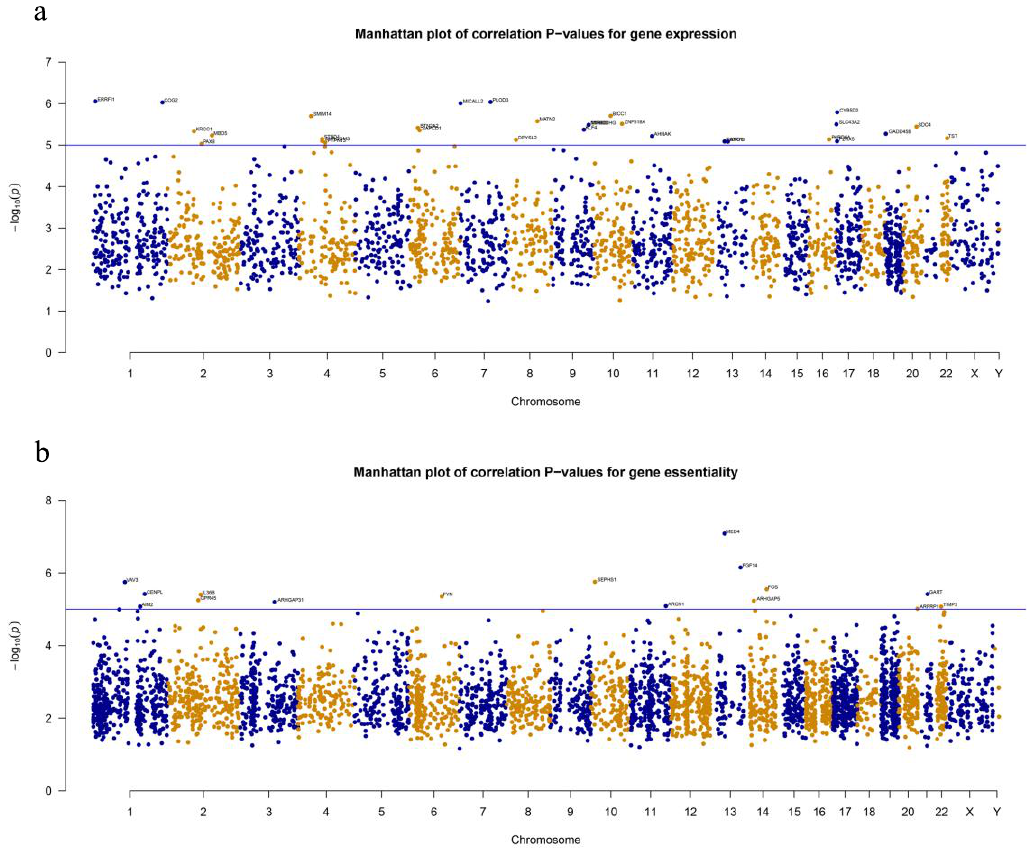
Figure 2. Manhattan plots of correlation p -values. ( a ) Gene expression data, ( b ) gene essentiality data.